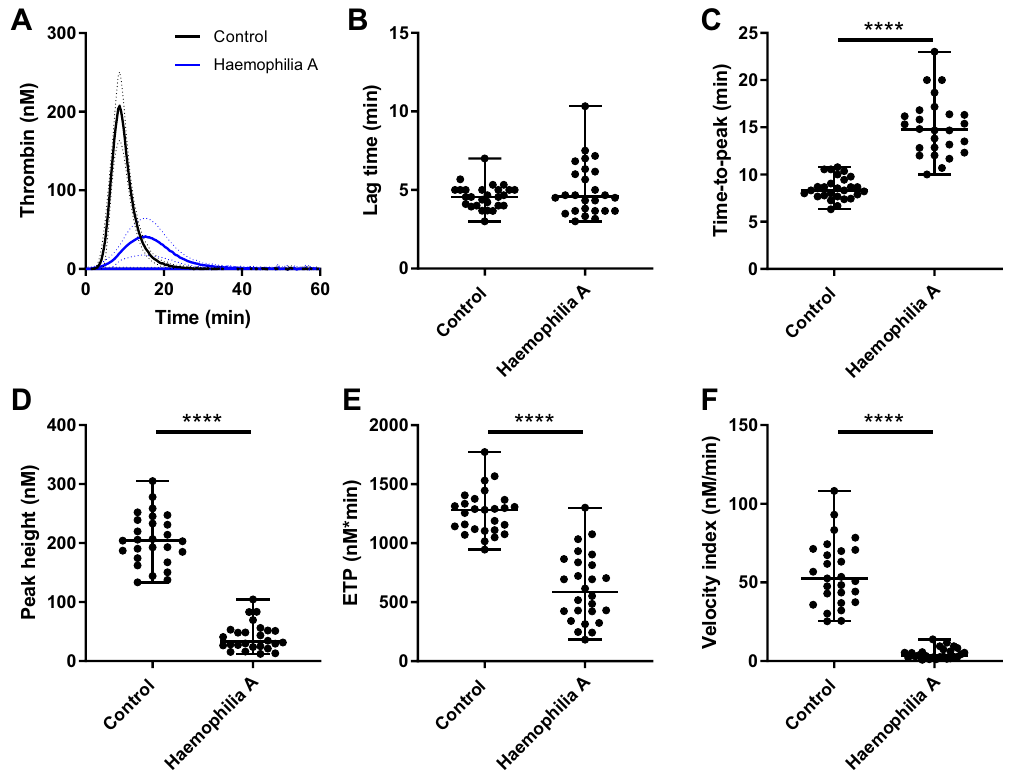
Figure 1. Thrombin generation in haemophilia A triggered with 1 pM tissue factor. TG was triggered with 1 pM TF and the average curves for the patient and control group are shown in ( A ). Individual TG curves were quantified by the lag time ( B ), time-to-peak ( C ), peak height ( D ), endogenous thrombin potential ( E ) and velocity index ( F ). TG curves are depicted as the mean curve (continuous line) ± the 95% confidence interval (dotted lines) and the parameter values are shown as the individual values with the median ± interquartile range. Statistical significance according to the Mann Whitney test is indicated as **** for a p -value <